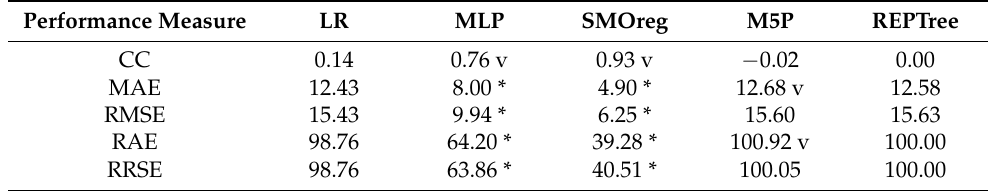
Table 6. Model comparison when using eye-tracking data. The asterisk (*) indicates statistically significantly worse and (v) indicates statistically significantly